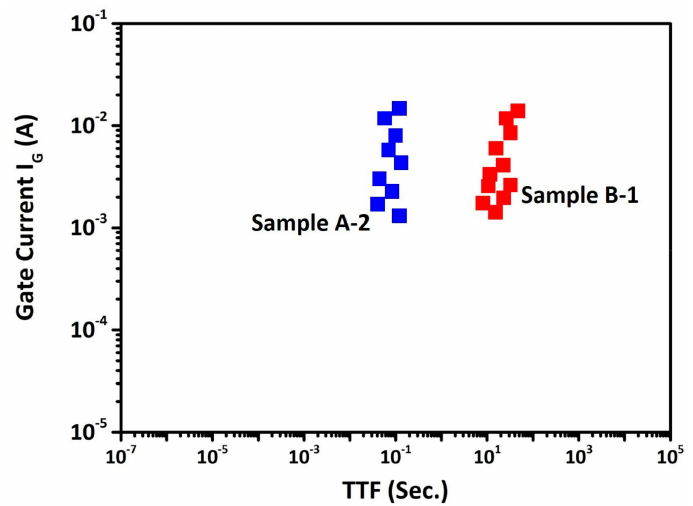
Figure 7. Correlation between gate current and time to failure (TTF) for the device under an HTGB at V G = 10 V, T = 150 ◦